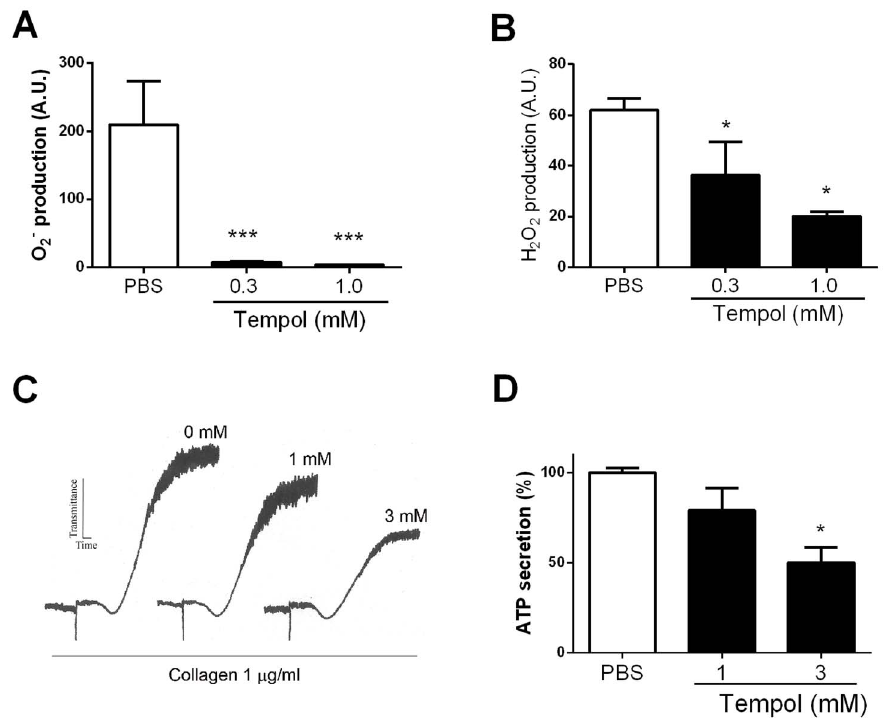
Figure 2. Tempol inhibits neutrophil and platelet pro-hemostatic functions. A, Inhibition of superoxide production. HL-60 cells were incubated with Tempol (0, 0.3, and 1 mM) followed by addition of f MLP (1 m M). Superoxide production was detected with Diogenes reagents. B, Inhibition of H 2 O 2 production. HL-60 cells were incubated with Tempol (0, 0.3, and 1 mM) followed by addition of f MLP (1 m M). H 2 O 2 production was detected with luminol/HRP-based chemiluminescence assay. C, Effects on platelet aggregation. Platelet-rich plasma was incubated with Tempol (0, 1, and 3 mM) for three hours and activated with collagen (1 m g/mL). A representative tracing is shown (similar results obtained with two other donors). D, Effects on platelet secretion. Platelets were activated as above, and ATP was determined by luminescence using Luciferin-luciferase reagent. Experiments were performed in triplicate or quadruplicate. *, P # 0.05 (analysis of variance, Bonferroni post-test).